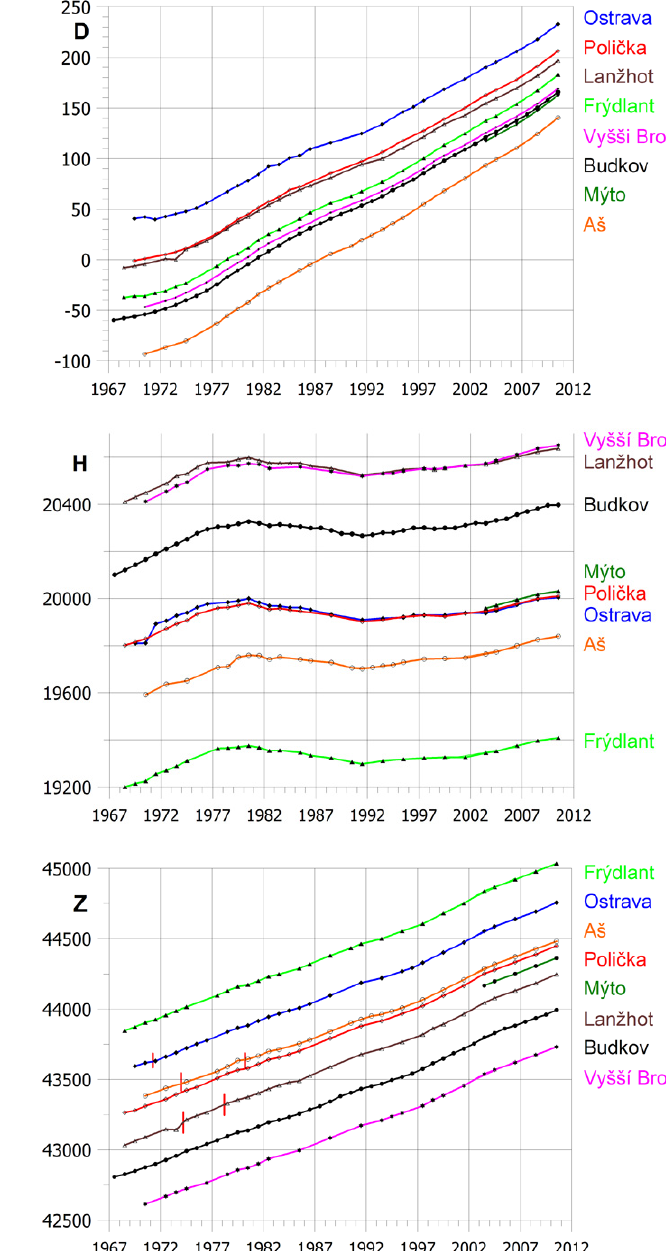
Figure 1 (left column, top to bottom, up to horizontal line). Maps of the geomagnetic field for the epoch 1995.5 based on the magnetic survey carried out between 1994 and 1996 [Hejda et al. 1999]. Declination is given in degrees of arc, contour interval is 0.1 degree. Horizontal and vertical components are given in nT, contour interval is 100 nT. Figure 2 (left). Czech repeat stations and neighboring observatories used for modeling of the secular variation. Figure 3 (right column, top to bottom). Repeat station measurements on the territory of the Czech Republic and Budkov observatory data. All values were reduced to the yyyy.5 epoch. Declination is given in minutes of arc, horizontal and vertical components are given in